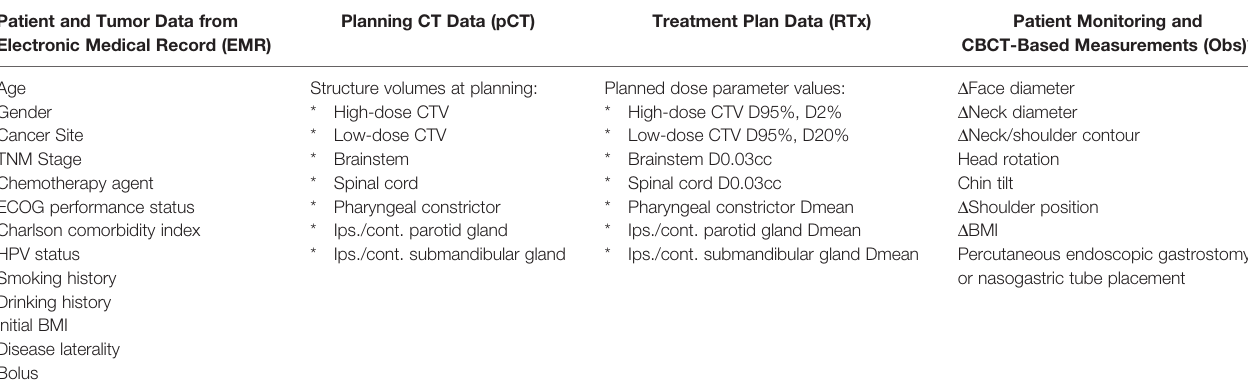
TABLE 2 | Input data and categories used for RF model